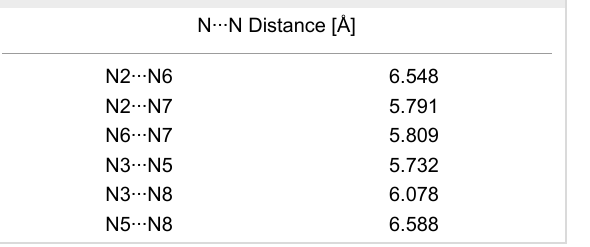
Table 5: Selected non-bonded distance (Å) of complex 2 .